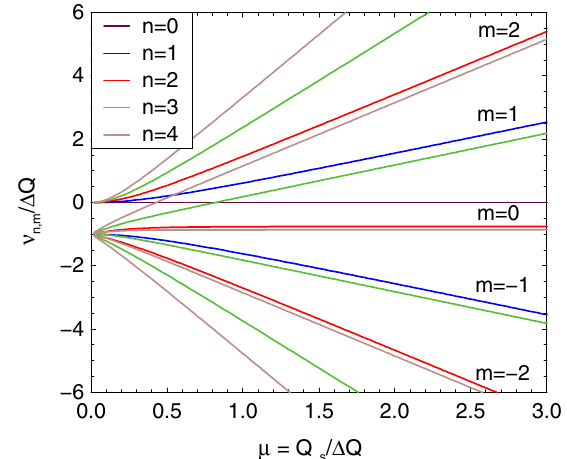
FIG. 2. Eigentunes of the boxcar bunch against synchrotron tune. Space charge tune shift (cid:1) Q is used as a scaling factor. Two families of the tunes, starting from the points 0 and (cid:1) 1 at (cid:17) ¼ 0 , unite into multipoles at large (cid:17) .